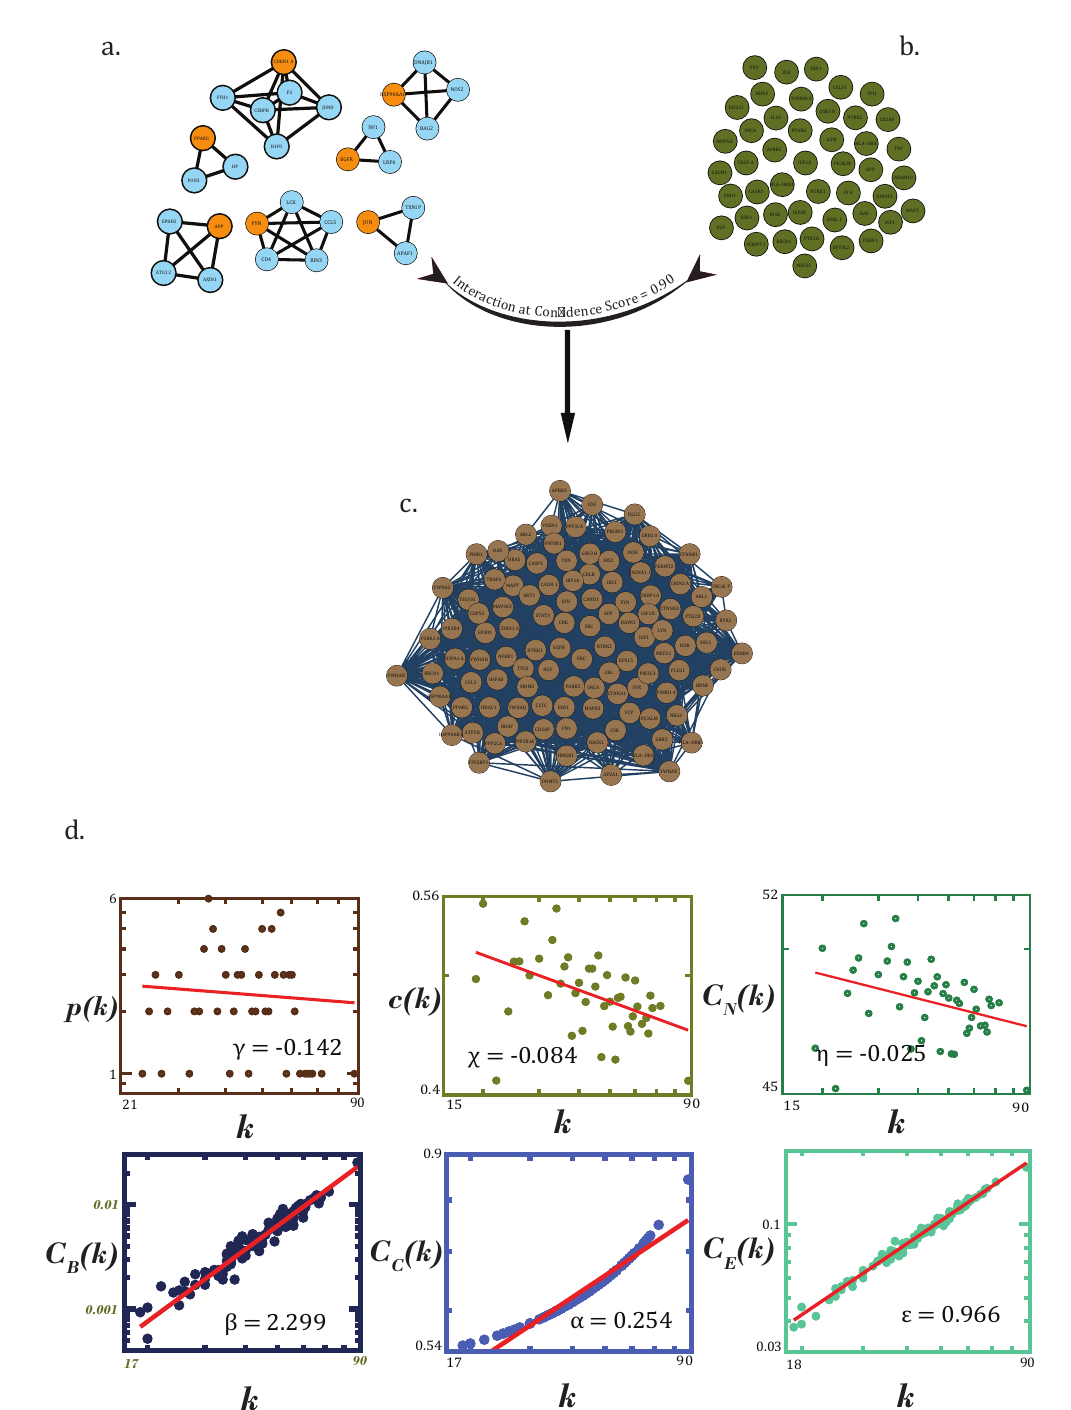
Figure 6. ( a ) All motif-localized hubs (total of 95) in the principal dementia network. ( b ) Noise- filtered drug-associated genes. ( c ) Resultant network ( a – c ). Construction of resultant “druggable genome–motif-localized hubs/stability” network consisting of high confidence, and interactions among motif-localized hubs were experimentally verified and filtered for noise drug-associated genes. ( d ) Topological properties (degree distribution p(k), average clustering coefficient c(k), neighbour- hood connectivity distribution C N (k), betweenness centrality C B (k), closeness centrality C C (k) and eigenvector centrality C E (k) of resultant